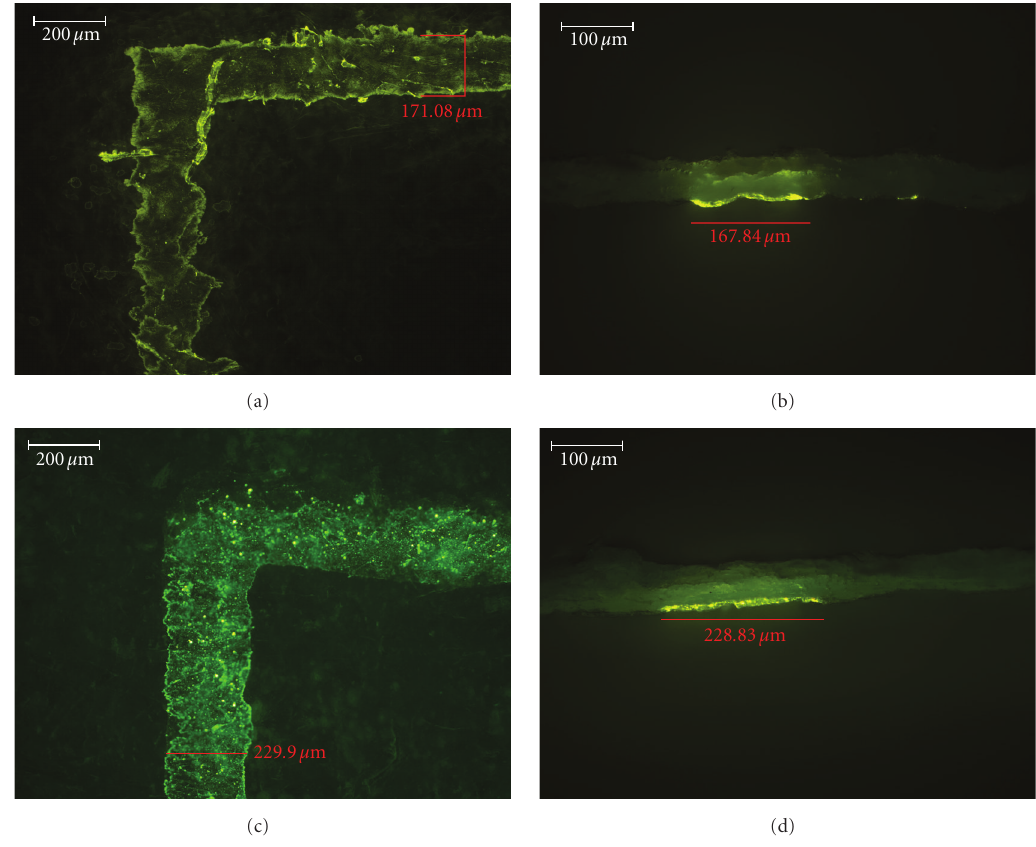
Figure 6: Fluorescence microscopy pictures of one right angle and of the slide of printed square on the tracing paper. Inkjet printing (a and b); Flexography (c and d). Table 1: Ink and support